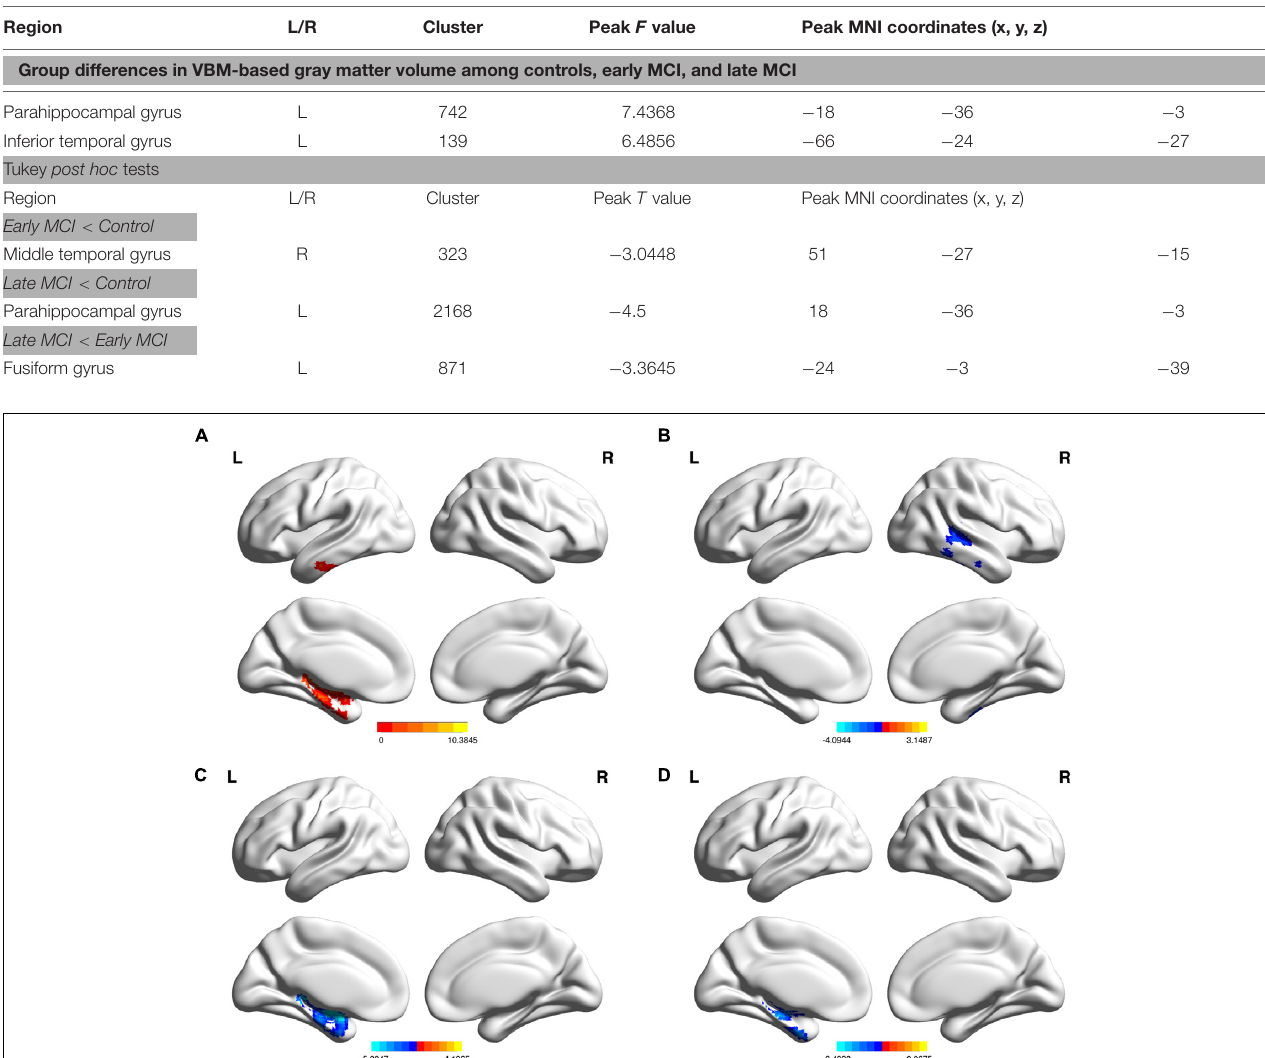
TABLE 2 | Anatomical location of regions showing differences in VBM-based gray matter volume. Region L/R Cluster Peak F value Peak MNI coordinates (x, y, z) Group differences in VBM-based gray matter volume among controls, early MCI, and late MCI Parahippocampal gyrus L